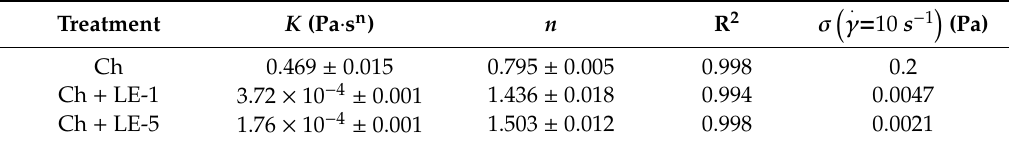
Table 4. Power Law parameters obtained for the edible coating solutions. Ch = Chitosan; Ch + LE-1 = Chitosan + 1% of licorice extract; Ch + LE-5 = Chitosan + 5% of licorice